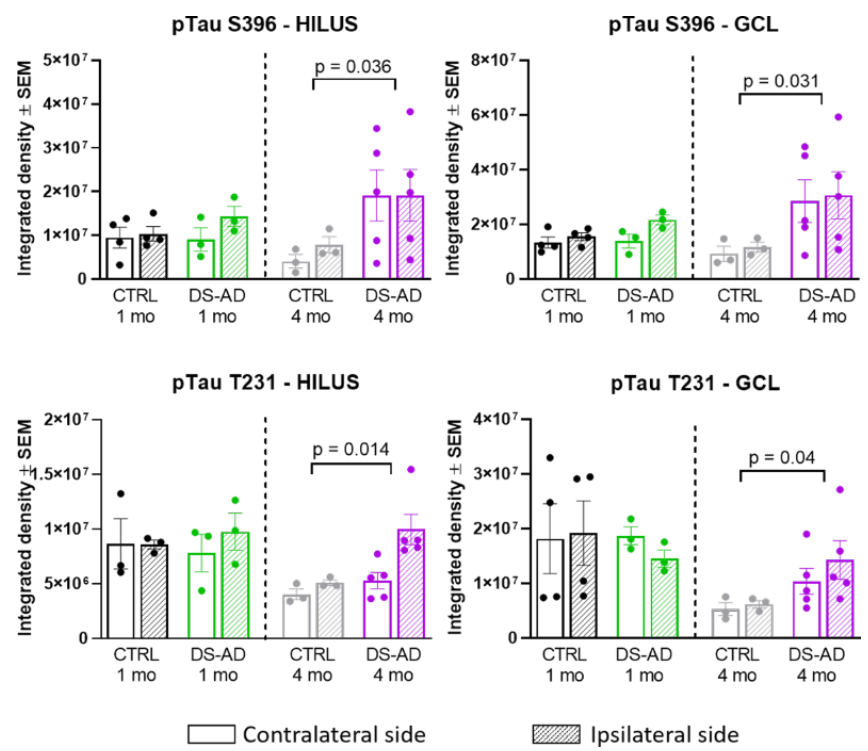
Figure 6. Densitometry of p-Tau S396, and p-Tau T231 in the Hilar region ( left panels ) and the GCL ( right panels ) of the hippocampus. There was a significant increase in p-Tau S396 staining in the Hilar region between DS-AD and controls at 4 months ( p = 0.03) and in the GCL ( p = 0.03). In addition, there was a significant increase in T231 p-Tau after 4 months in mice injected with DS-AD vs. Controls in the hilar region ( p = 0.014) and in the GCL ( p = 0.04).